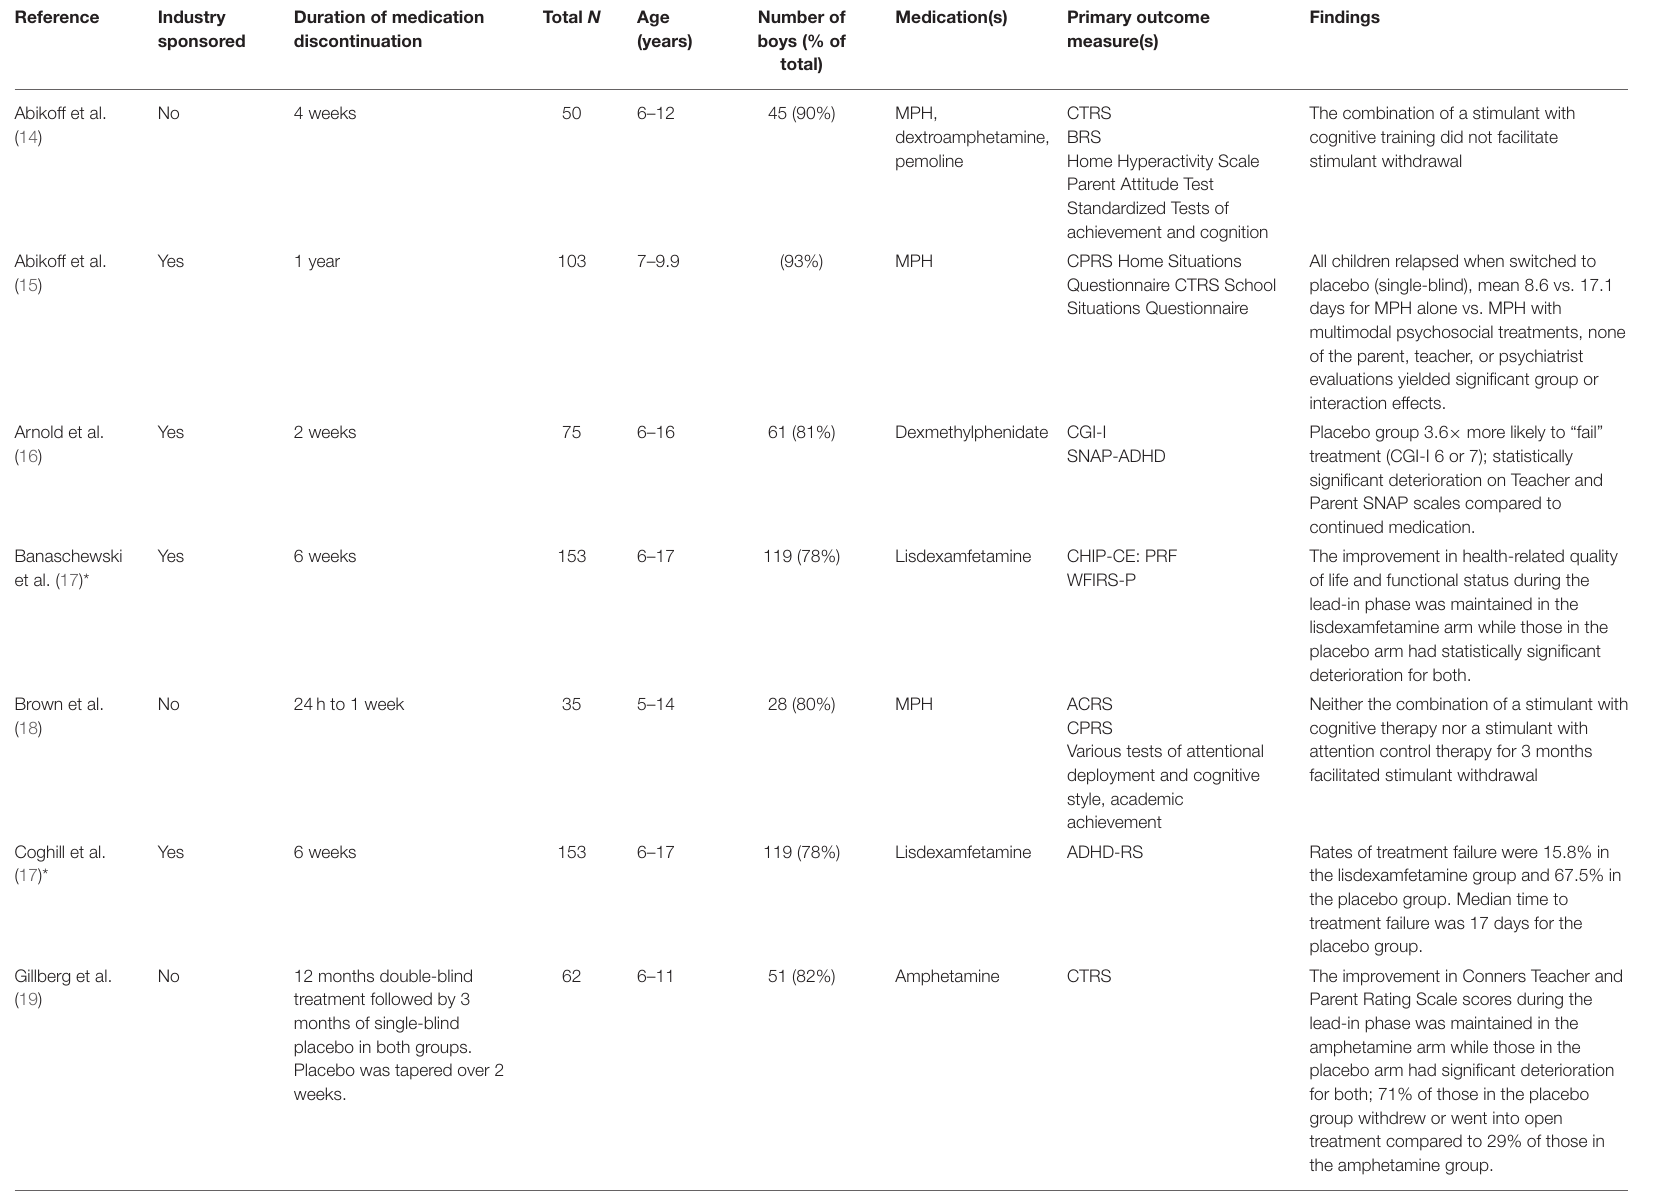
TABLE 1 | Randomized controlled trials that address discontinuation of psychostimulants in children with